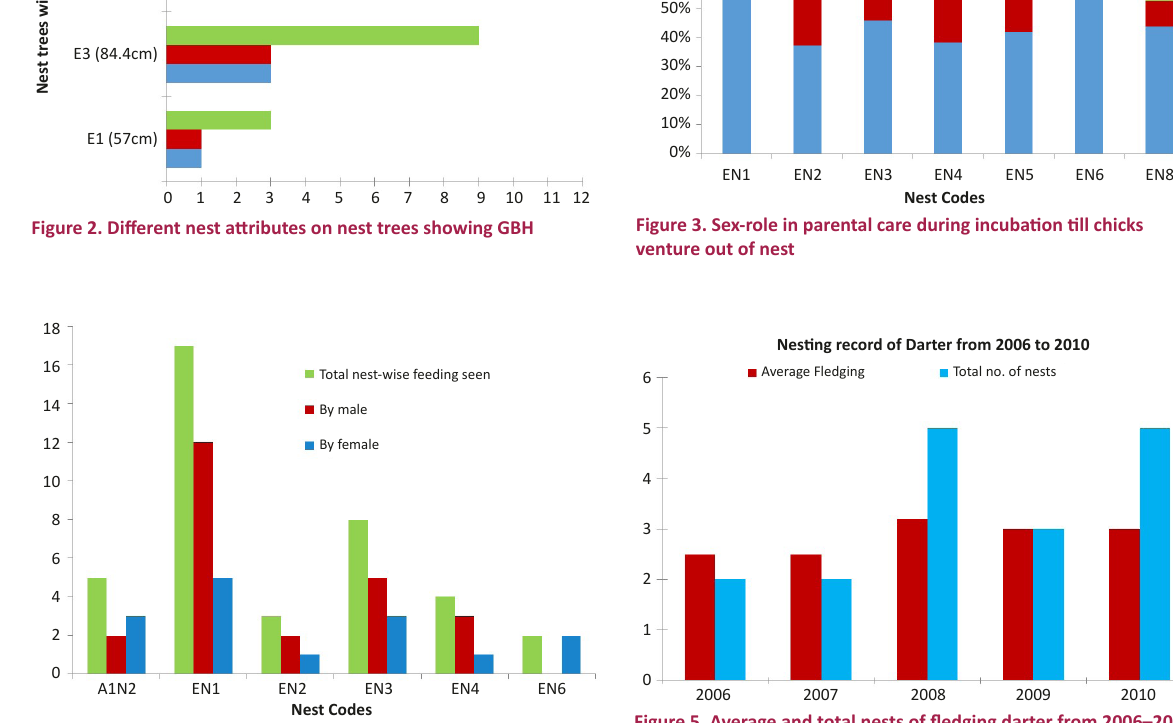
Figure 4. Sex-role differences in nest-wise nestling feeding